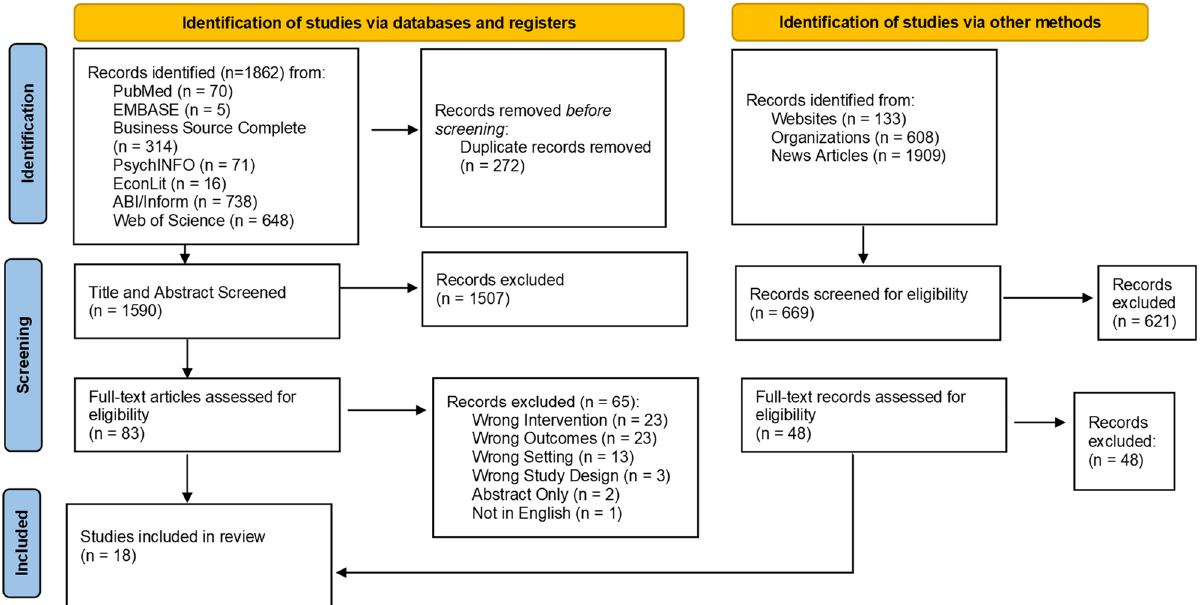
Figure 1. Flow diagram of studies included in the systematic review. Notes. Adapted from Page MJ, McKenzie JE, Bossuyt PM, Boutron I, Hoffmann TC, Mulrow CD, et al., “PRISMA 2020 flow diagram for new systematic reviews which included searches of databases, registers, and other sources.” The PRISMA 2020 statement: an updated guideline for reporting systematic reviews. BMJ, 372. doi:10.1136/bmj.n71.